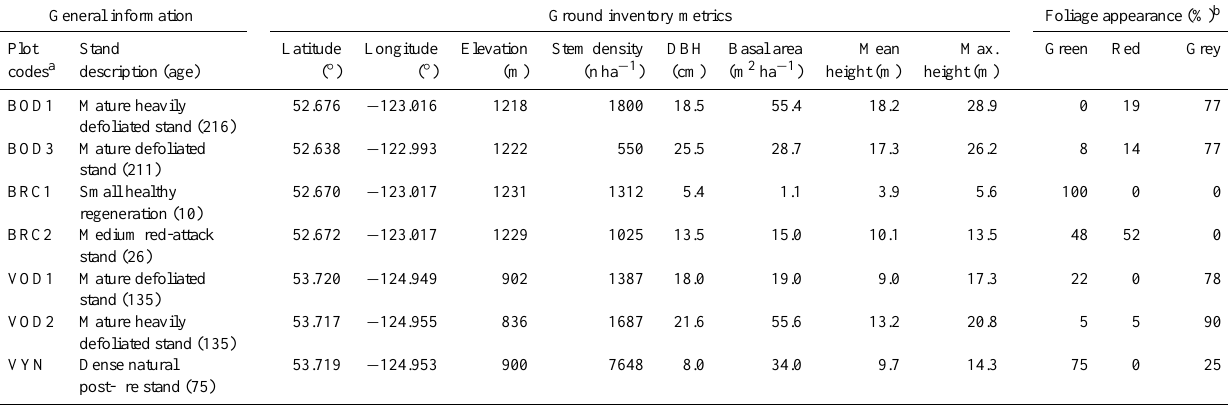
Table 1. Stand locations and physical characteristics as of 2008. General information